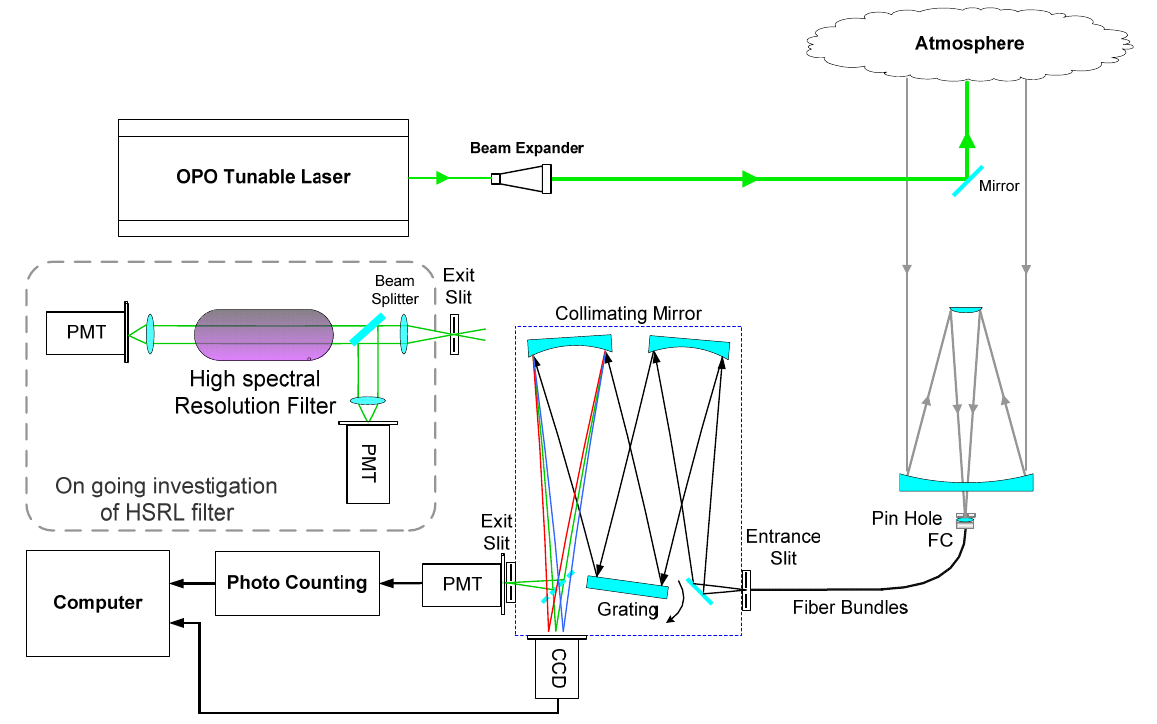
Figure 2. Optical layout of the Fraunhofer lidar prototype.